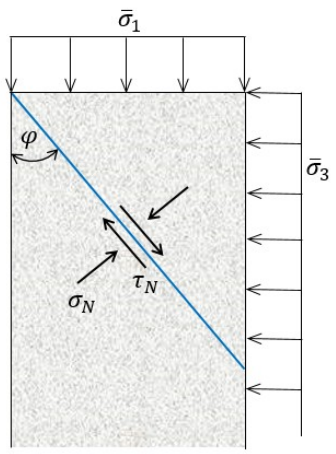
Figure 12. Shear-friction plane mechanism.